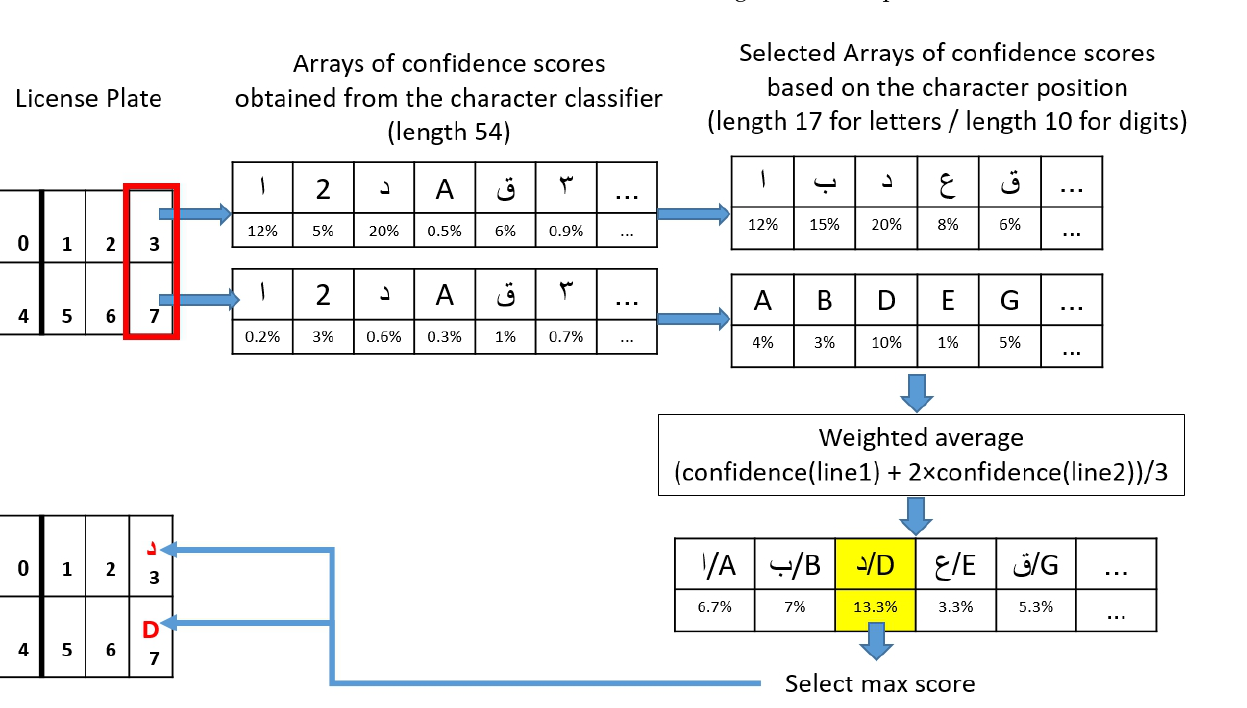
Figure 8. Post-processing of the character classifier output in the single-character detection